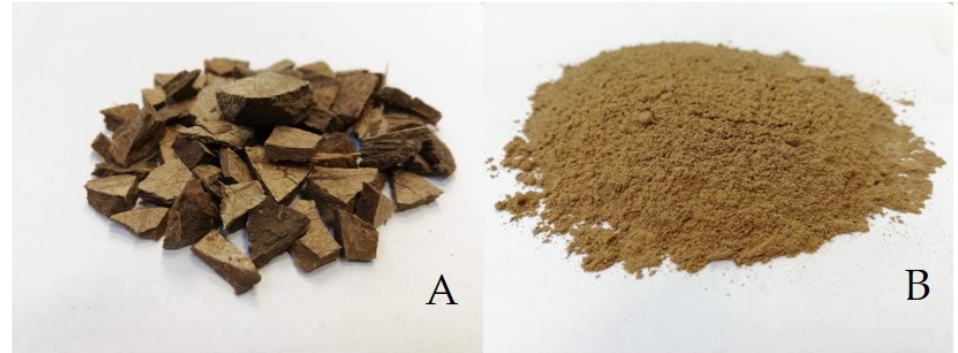
Figure 1. Waste from coconut oil production: ( A ): pre-crushed coconut shells, ( B ): natural particulate filler from coconut shells.